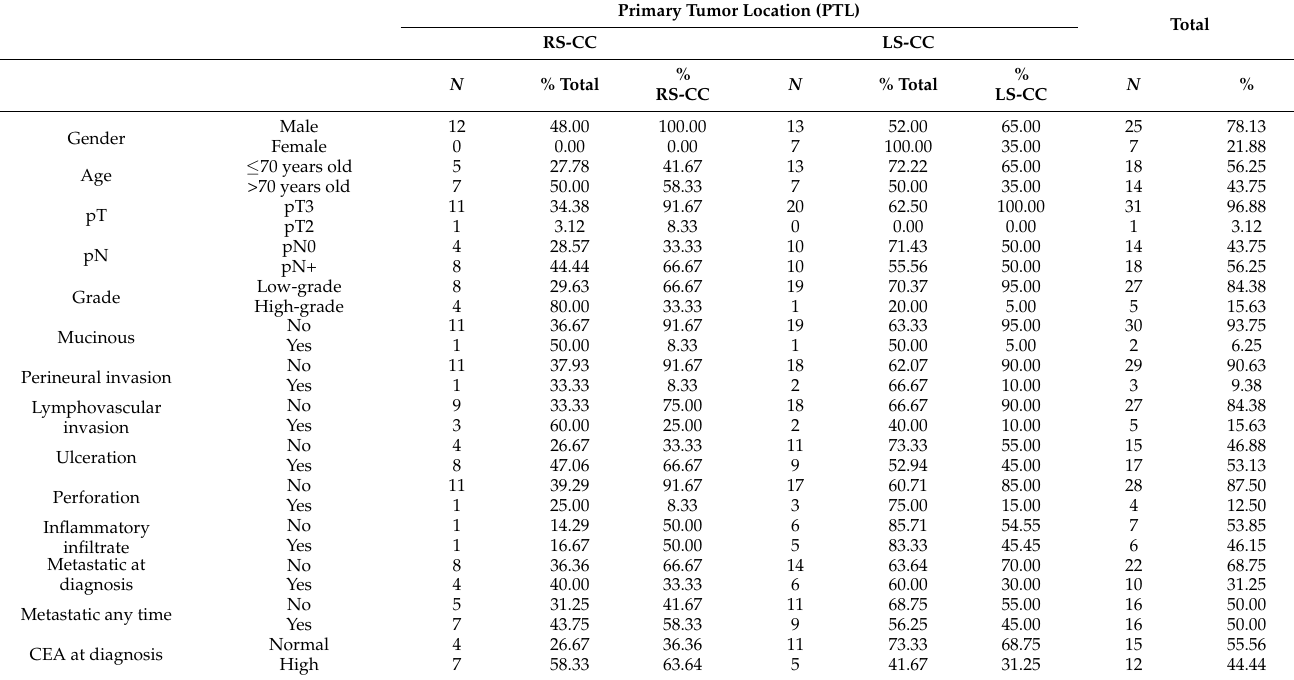
Table 1. Summary of the clinical data of the